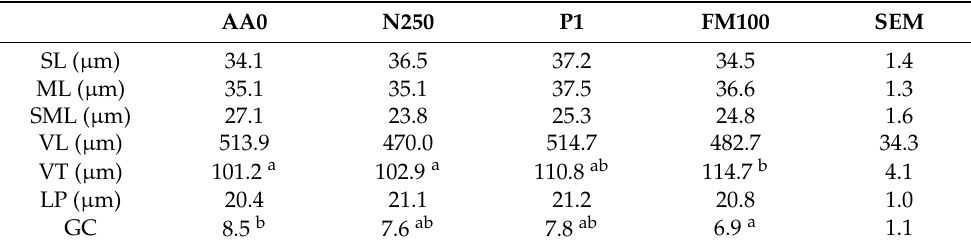
Table 6. Effect of the different experimental diets on proximal intestine parameters.